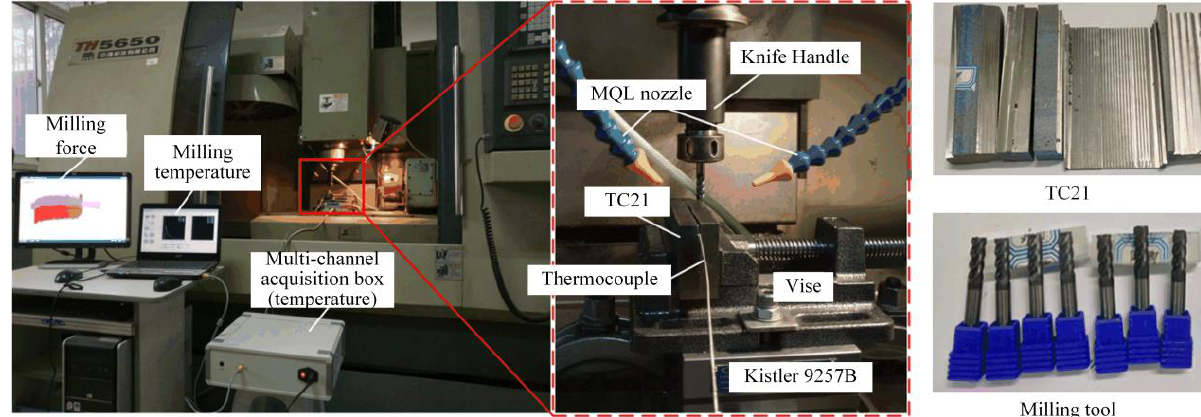
Figure 1. The experimental system for milling machining.